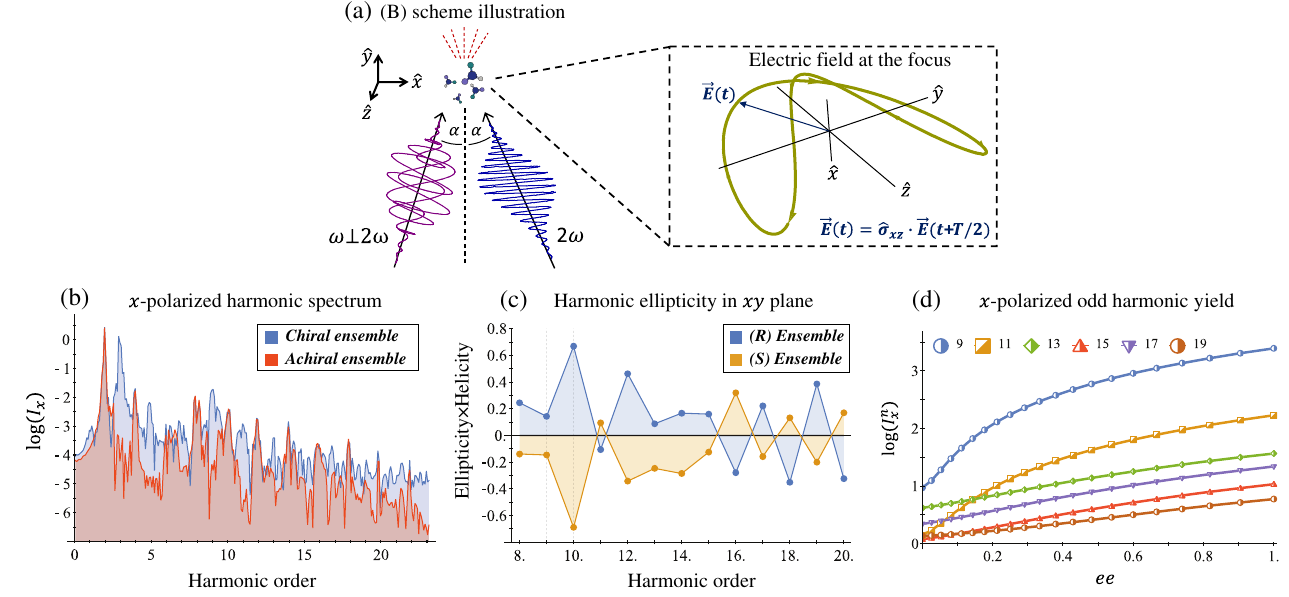
FIG. 3. Dynamical reflection symmetry-breaking-based chirality detection in HHG: Numerical model potential results. (a) Illustration of scheme (B) with the pump field in Eq. (11). The inset shows the 3D Lissajou plot of the microscopic electric field vector in the focus, which exhibits a dynamical reflection symmetry (arrows along the Lissajou represent the direction of time). (b) x -polarized high harmonics emitted from the chiral and achiral ensembles ( ψ 6 in the model potential), for fundamental wavelength λ ¼ 900 nm, I 4 . 2 × 10 13 W = cm 2 , ϕ ¼ π = 9 , Δ 1 . 1 , Δ 0 . 97 , α ¼ 15 0 , and a trapezoidal envelope with four-cycle turn-on/off and four- 1 ¼ 2 ¼ max ¼ cycle flattop. (c) Calculated harmonic ellipticities in the xy plane from (R) and (S) ensembles — the helicity changes sign with the medium ’ s handedness. (d) Integrated power of the y -polarized odd harmonics 9 – 19 vs the ee in log